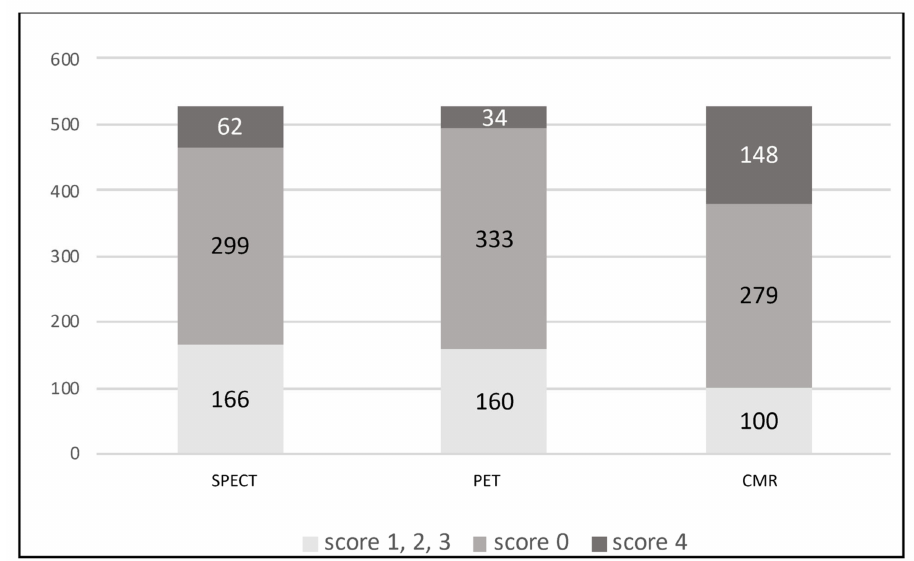
Figure 1. Segmental analysis of myocardial viability in 527 segments within different imaging